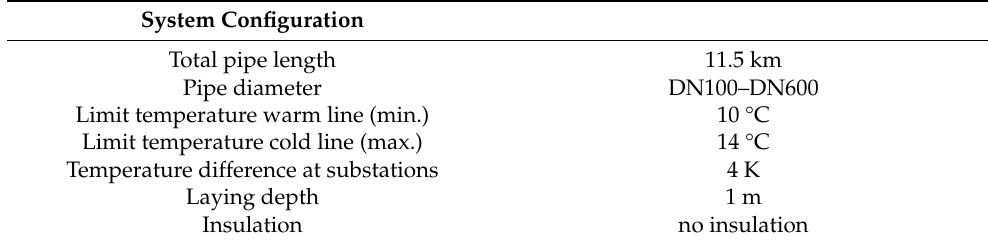
Table 4. Configuration of the low-temperature network in baseline